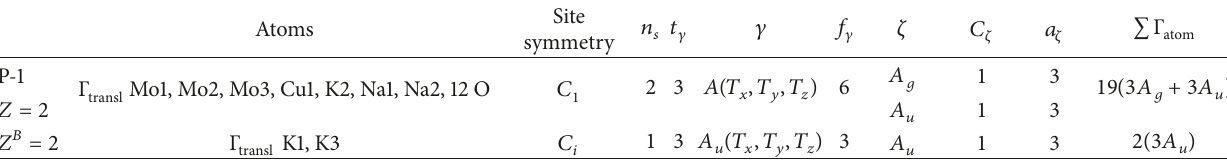
Table 4: Factor group analysis of the triclinic phase Na 2 K 2 Cu(MoO 4 ) 3 .